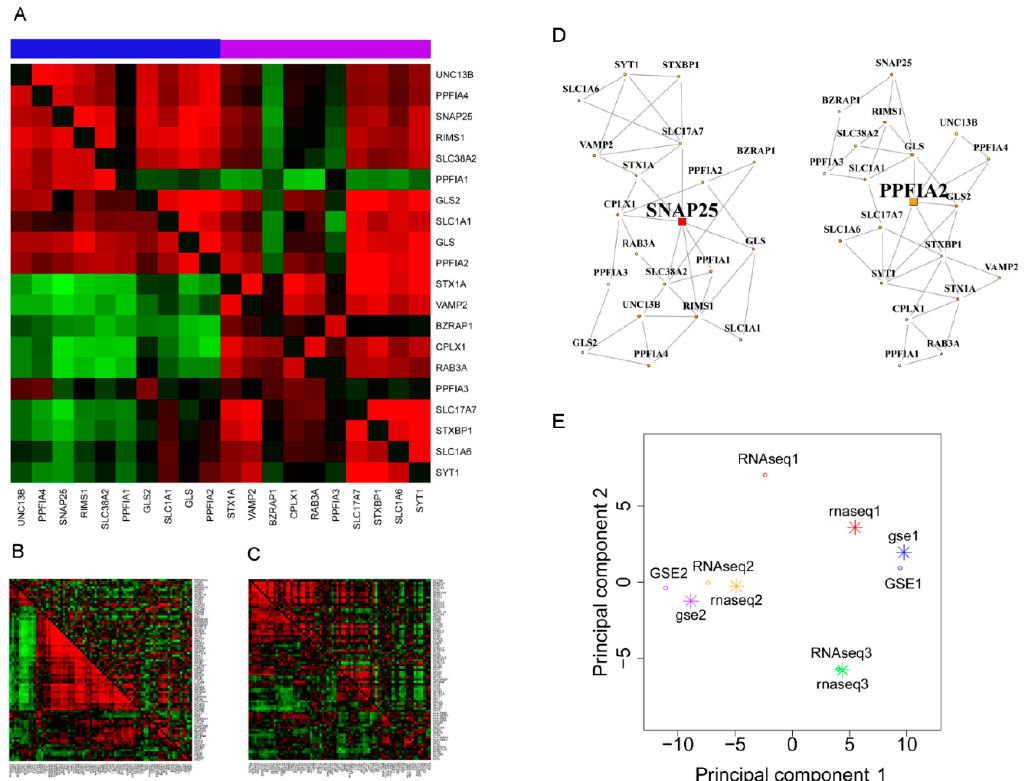
Figure 2. Internal correlation rewiring of pathways perturbed in schizophrenia (SCZ). ( A – C ) correlation coefficient heatmaps for three pathways: “glutamate neurotransmitter release cycle” ( A ), “L1CAM interactions” ( B ), and “MHC class II antigen presentation” ( C ). The three heatmaps are derived from expression datasets GSE1, RNAseq3, and RNAseq1, respectively. In each heatmap, the lower triangle and the upper triangle cover gene-gene co-expression level in the control and SCZ groups, respectively. The color bar on top of the heatmap indicates two subgroups of “glutamate neurotransmitter release cycle” genes in the normal condition. ( D ) Gene co-expression networks formed by 20 genes of pathway “glutamate neurotransmitter release cycle” (data source: GSE1). Left, control; right, SCZ. Two highlighted genes ( SNAP25 and PPFIA2 ) are the hub gene in control and SCZ, respectively. Of note, a hub gene does not necessarily have the most connections in the network because it is identified as having the highest regulatory impact (overall co-expression synchrony with all other genes) rather than the highest degree. ( E ) Principal component analysis summarizes pathway rewiring result out of ten separate method-dataset combinations. Uppercase, results from gene sets net correlations analysis (GSNCA); lowercase, results from method gene set co-expression analysis (GSCA). RNAseq1, RNAseq2, RNAseq3, GSE1, and GSE2 are all gene expression dataset names, with details given in Table 1.